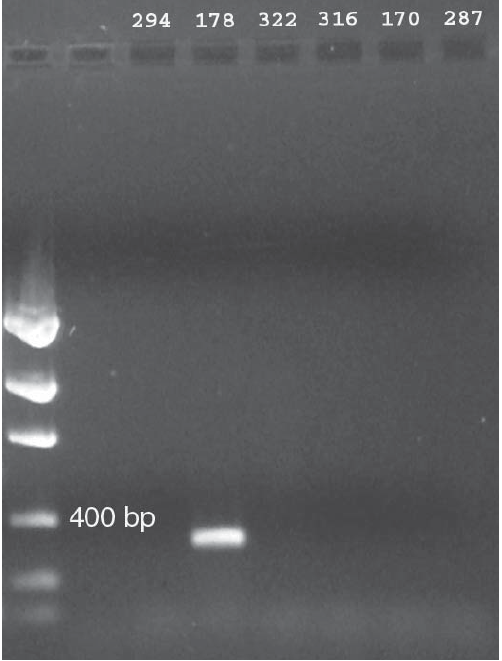
Fig. 2. Gel electrophoresis of real-time PCR products for Phaeomoniella chlamydospora (Pch) primer verifi- cation: 287 ( P. aleophilum ), 170 ( P. mortoniae ), 316 ( P. angustius/P. viticola ), 322 ( P. rubrigenum ), 178 (Pch), 294 ( Cadophora cf. malorum ). Note that non-target DNA 287, 170, 316, 322, and 294 were not amplified. The real- time PCR product was approximately 320 bp for